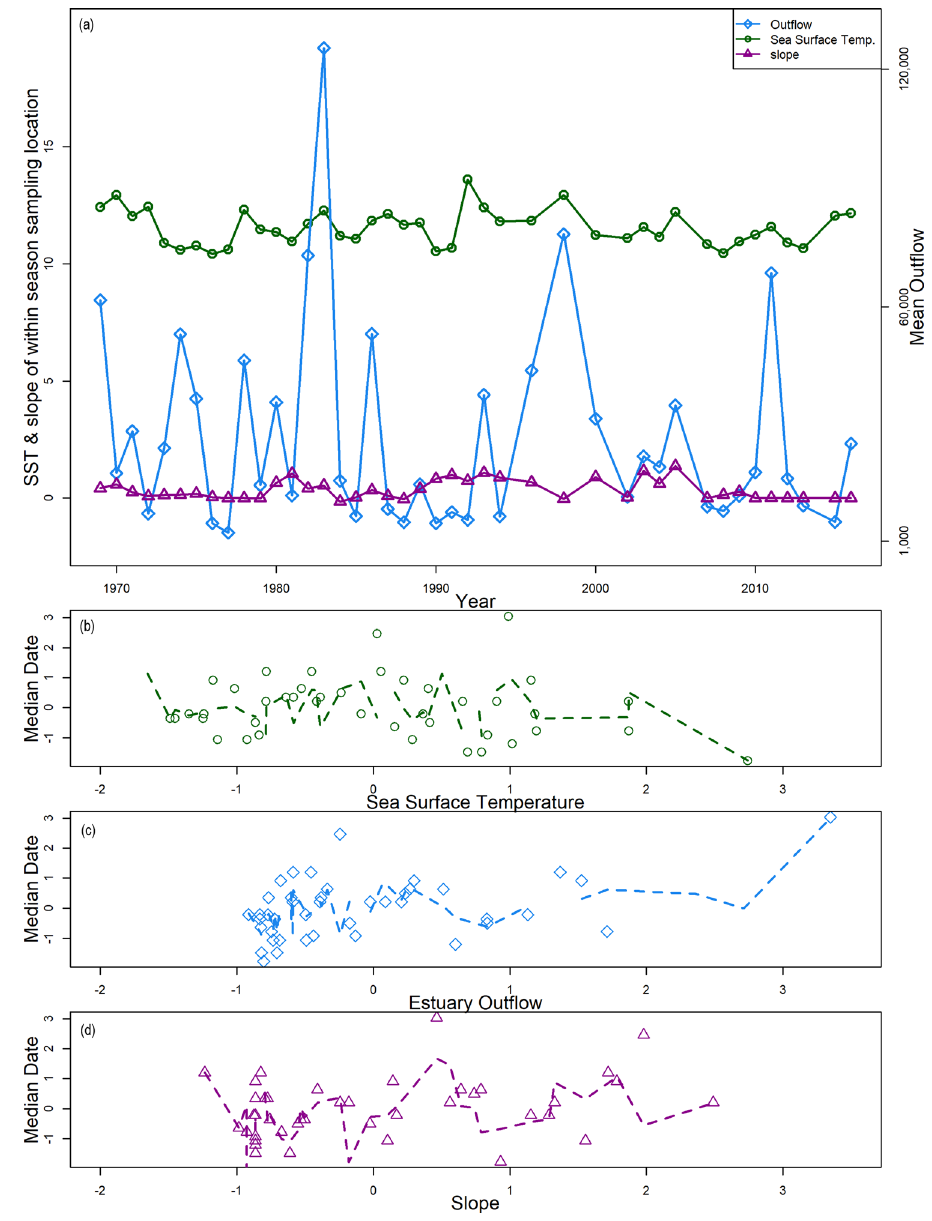
Figure 2. Parameters from the best model in Table 2 plotted through time ( a ) and against median migration date of adult Striped bass ( b – d ). Sea surface temperature (°C), mean Delta outflow (cfs), and the slope of within season sampling location are plotted by year ( a ). Then, sea surface temperature ( b ), mean Delta outflow ( c ) and the slope of within season sampling location ( d ) were z-scored and plotted against median date of migration with linear least squares regressions shown by dashed lines. Each variable from the best model in Table 2 is distinguished by color and symbol: sea surface temperature (°C) as green circles, mean Delta outflow (cfs) in blue diamonds, and the slope of within season sampling location denoted by purple